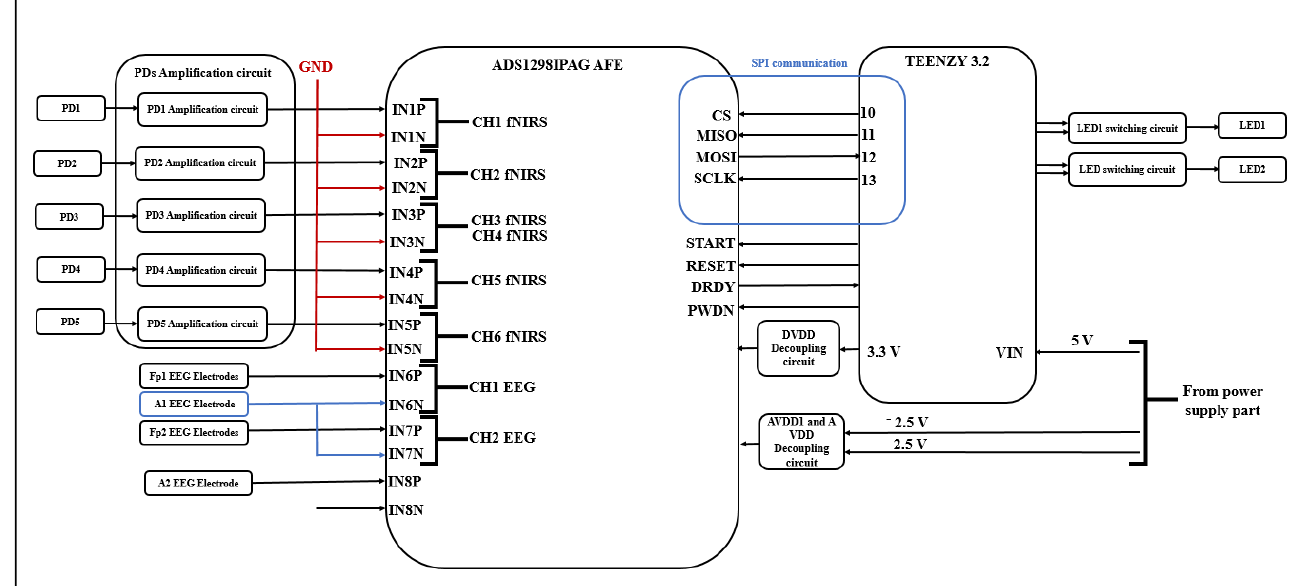
Figure 4. EEG/fNIRS measurement, control circuit and the communication between